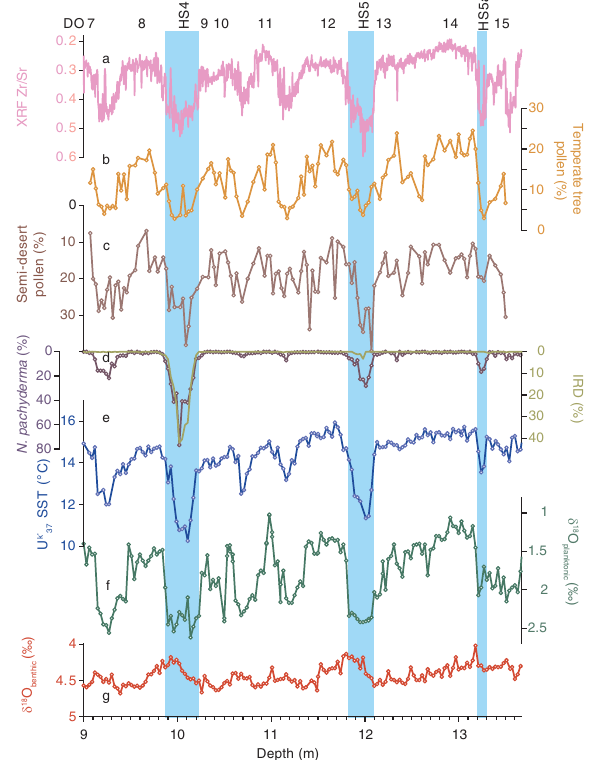
Fig. 1 MD01-2444 MIS 3 records plotted against depth (9 – 13.67 m). a XRF Zr/Sr record (this study). b Temperate (Mediterranean + Eurosiberian) tree pollen percentages (this study). c Pollen percentage of semi-desert taxa ( Artemisia and Chenopodiaceae/Amaranthaceae) (inverse scale) (this study). d Percent ice-rafted detritus (IRD) (inverse scale) and Neogloboquadrina pachyderma inverse scale) 33 . e Alkenone-based U k' 37 SST 34 . f Planktonic ( G. bulloides ) foraminiferal δ 18 O (ref. 33 ). g benthic foraminiferal δ 18 O (ref. 32 ). DO interstadials are indicated and vertical bars denote HS4, HS5 and